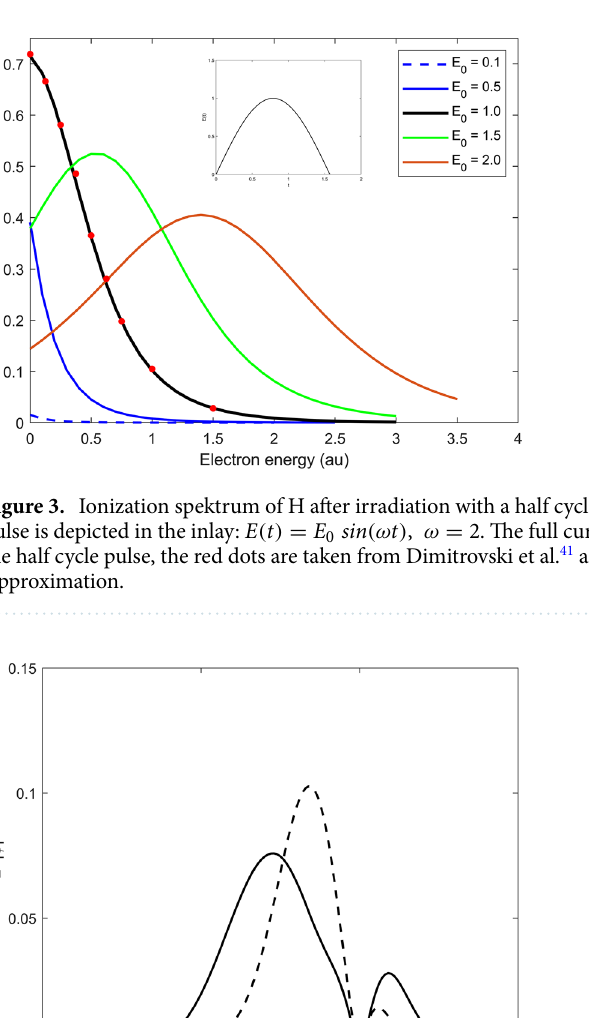
E sin (ω t ) , ω 2, E 0 0 = = =